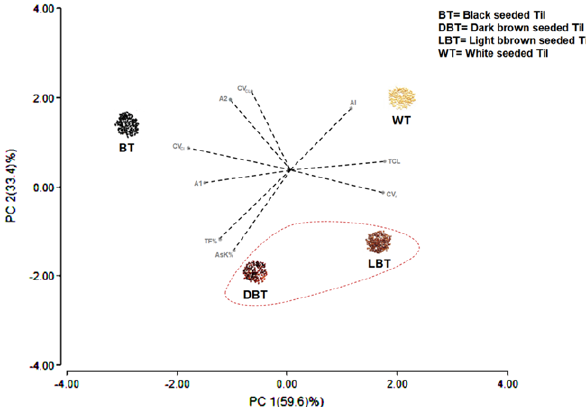
Figure 5. Principal component analysis (PCA) plot showing group- ing of four Indian landraces of S. indicum based on nine karyo- morphometric variables.